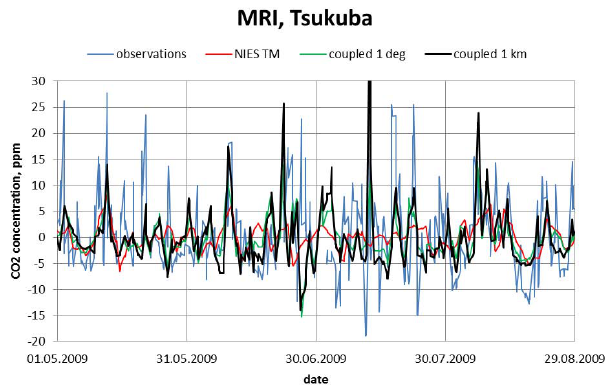
Fig. 3. Deseasonalized results for Fyodorovskoye tower (represen- tative 4-month time series).